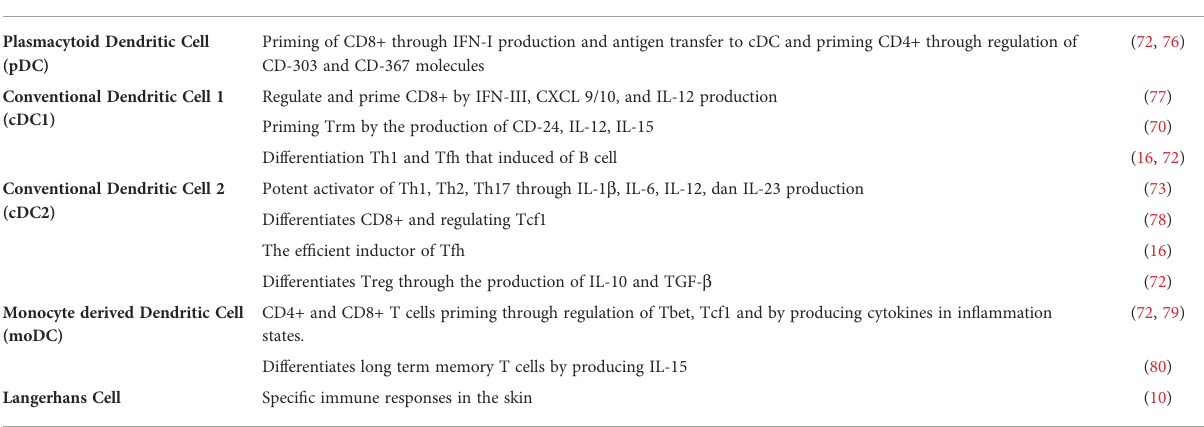
TABLE 1 Types of dendritic cells and their functions. Dendritic Cell Types